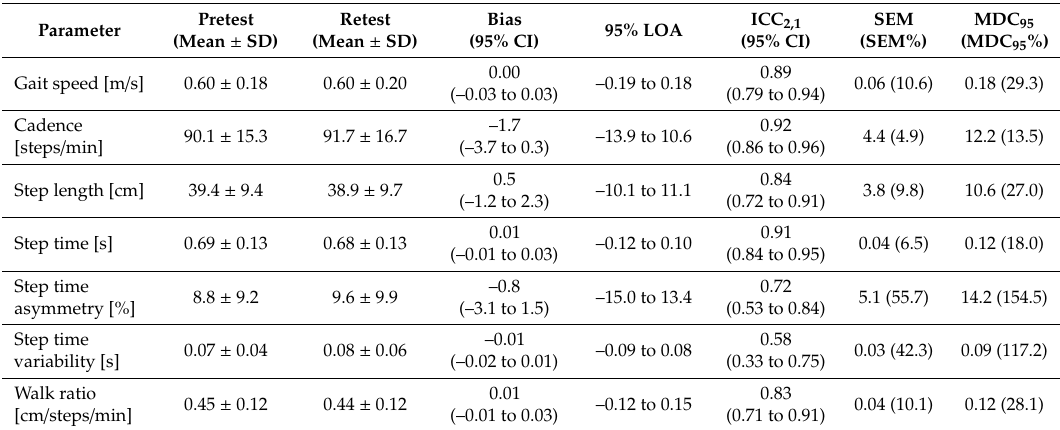
Table 3. Intra-session test-retest reliability of the DynaPort MT ( n = 40).